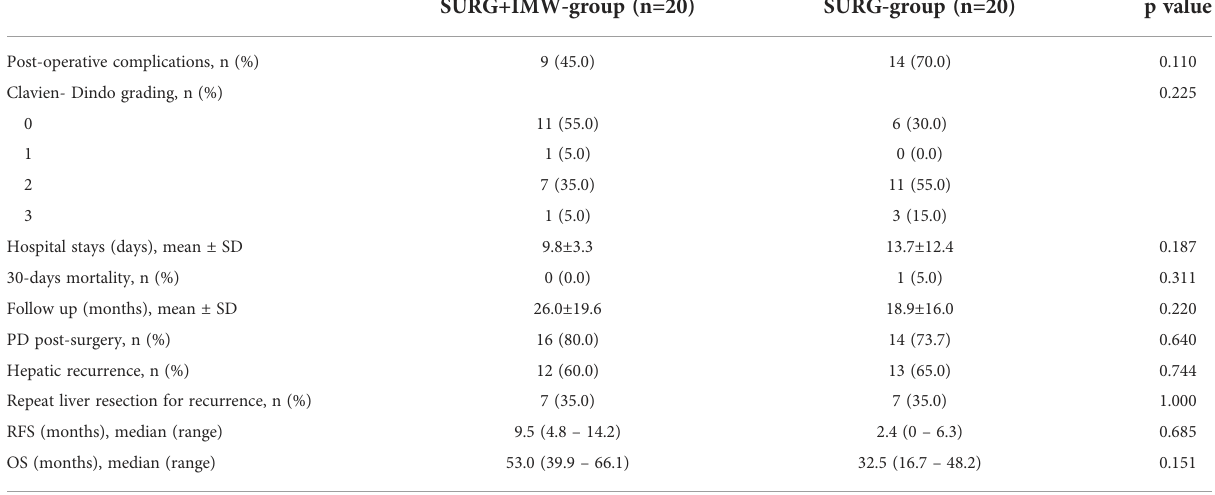
TABLE 3 Post-operative